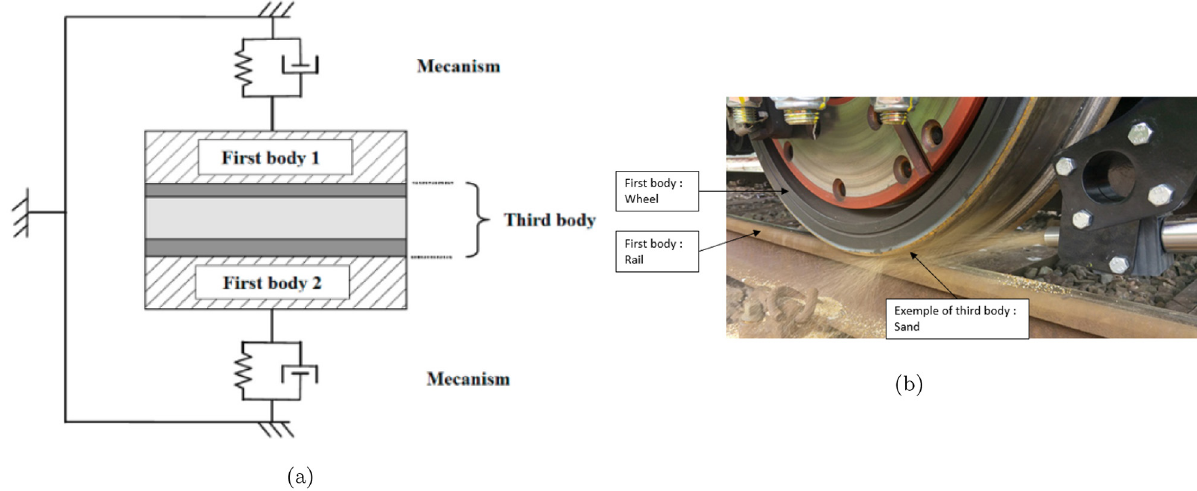
Fig. 2. (a) The tribological triplet by Godet and Berthier [3,4], (b) application to a sanding system for the wheel–rail contact.